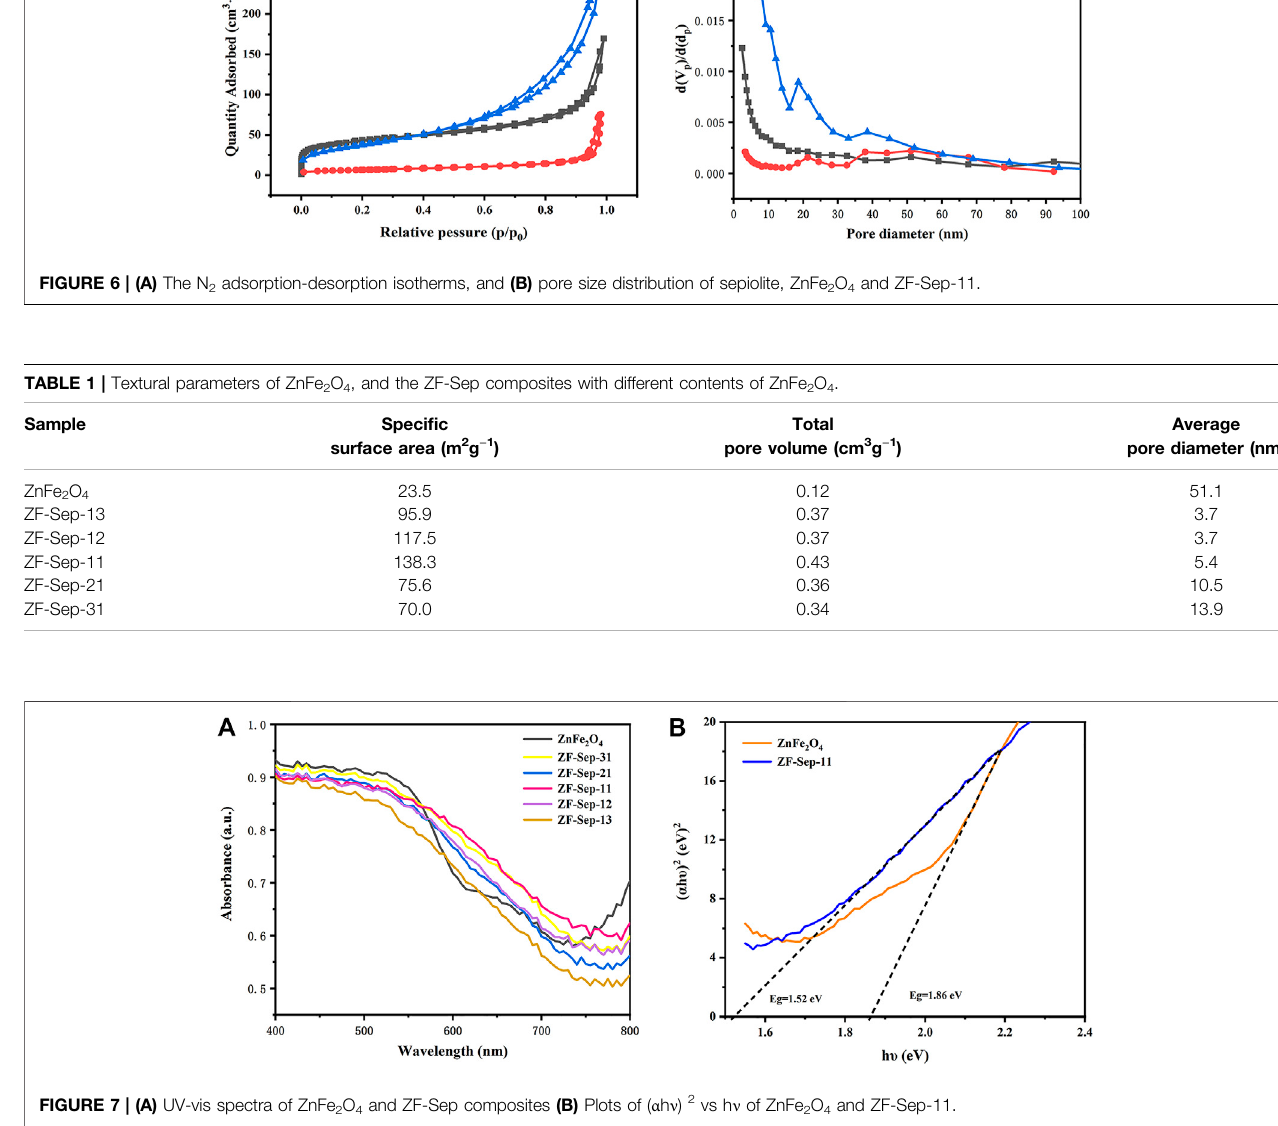
Frontiers in Chemistry |